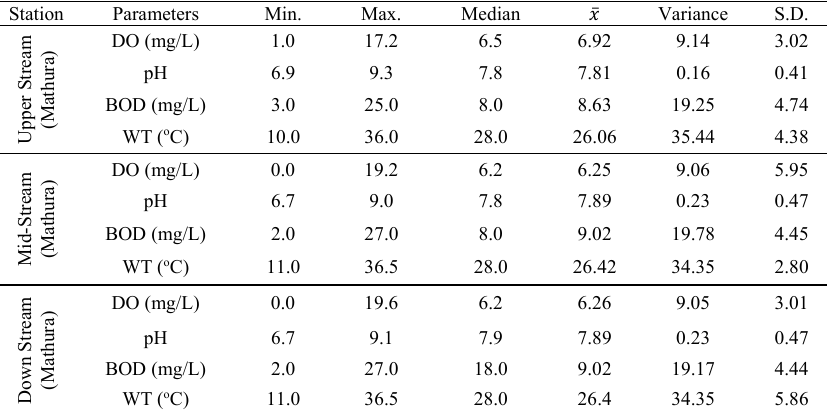
Table 1. Descriptive statistics of each parameter